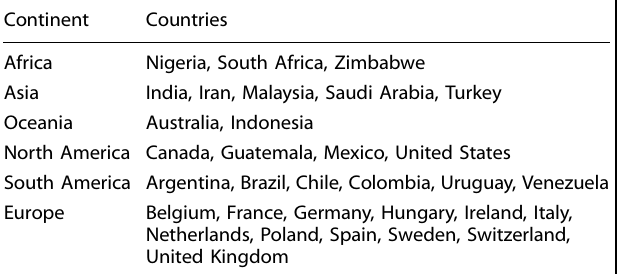
Table 3. Countries included in the study, categorized by